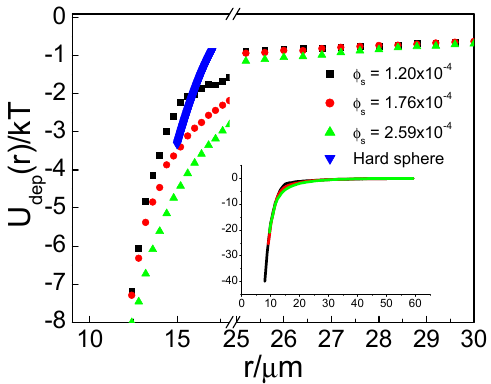
Colloids Interfaces 2020 , 4 , 36 11 of 15